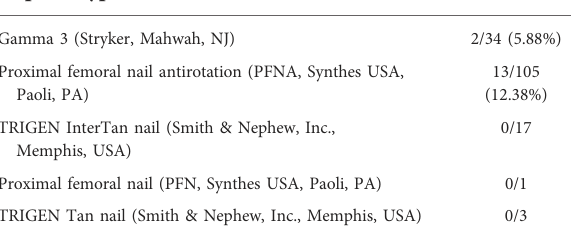
TABLE 1 Utilization of implant types. Implant type Failure